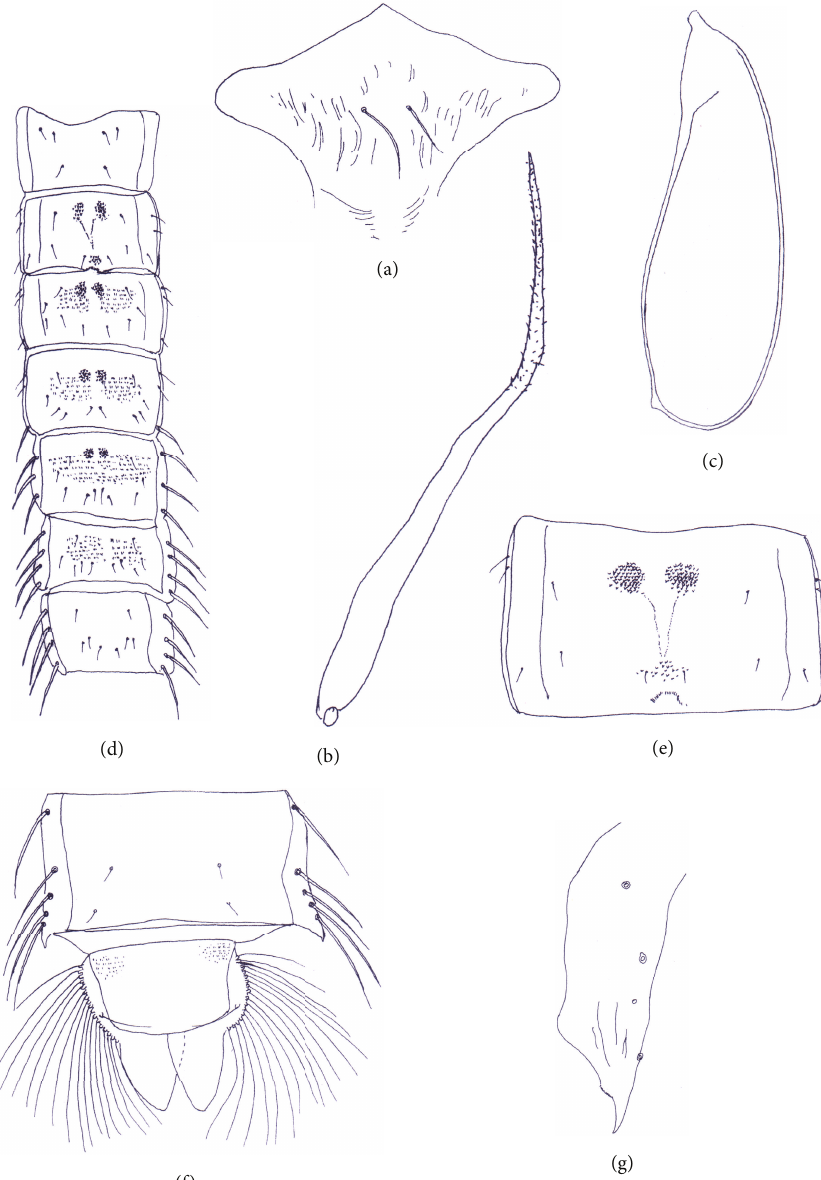
Figure 4: Rheotanytarsus spinicornus n. sp., pupa: (a) frontal apotome; (b) thoracic horn; (c) wing sheath; (d) tergites I–VII; (e) tergite II; (f) tergite VIII and anal lobe; and (g) caudolateral